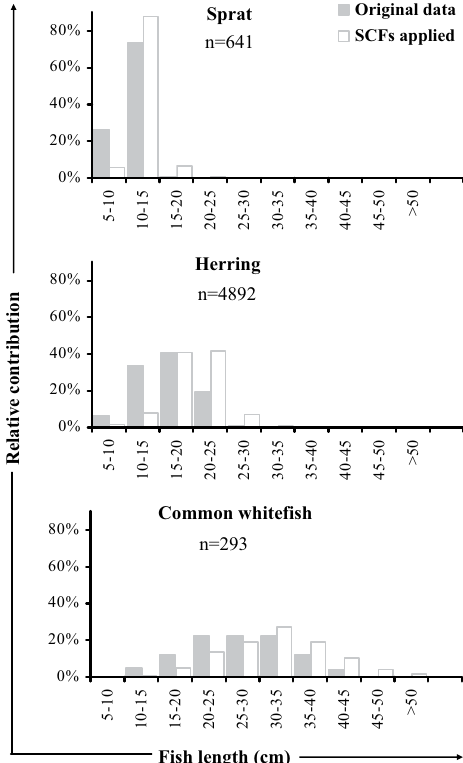
Fig. 6. Length compositions for sprat, herring and common whitefish based on digestive tract prey re - mains where n equals the number of sagittal otoliths used to estimate the fish lengths. Grey bars indicate length distribution based on original data and white bars indicate length distribution with size correction factors (SCFs)